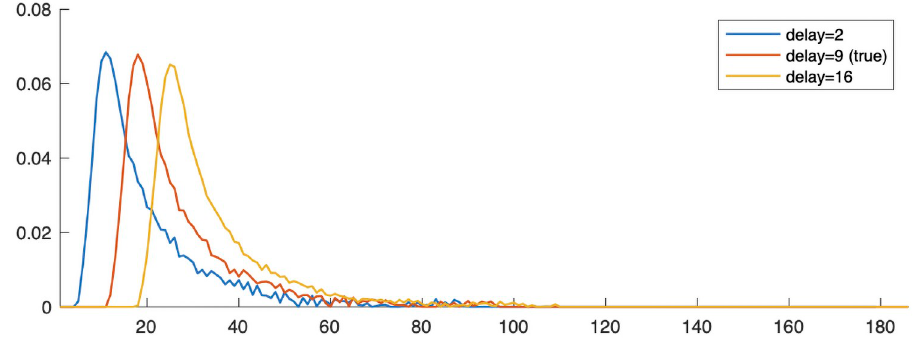
Fig 10. Investigation into the impact of selecting a different delay of the impulse response function in the nonlinear respirometry problem. Reconstructed impulse response functions ~ h are provided for different delays.